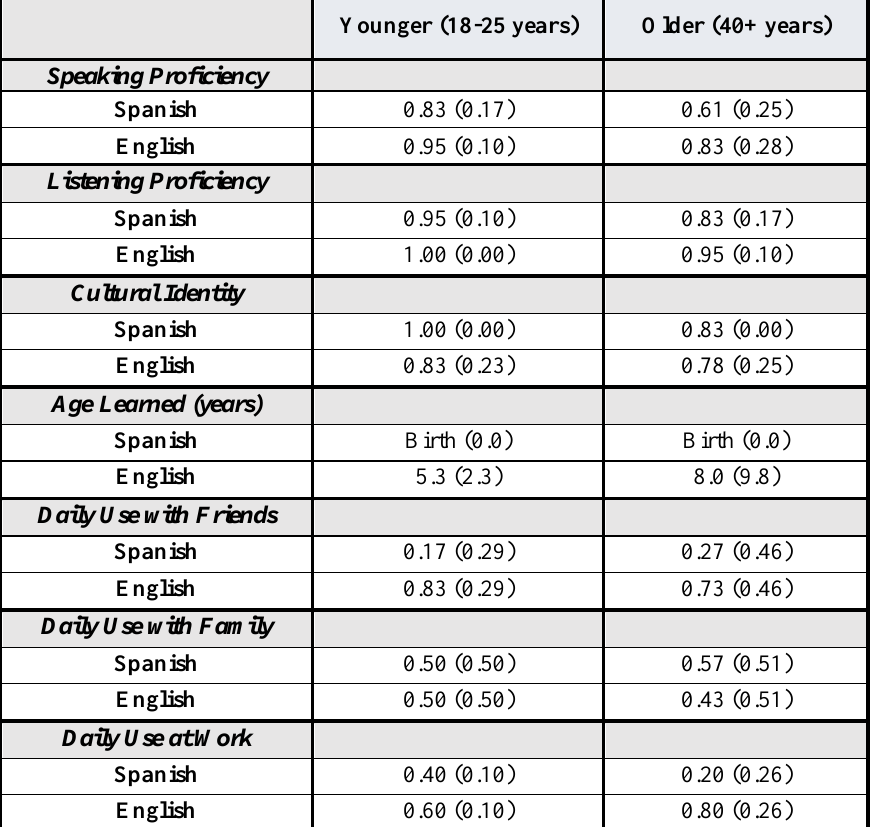
Table 1. Self-reported sociodemographic information across age groups for selected speakers in CBAS, mean responses are out of 1.0 (unless otherwise indicated) and are listed with standard deviations in